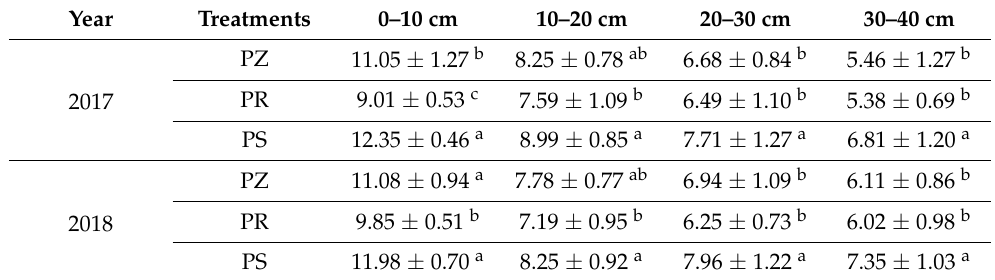
Table 5. Soil organic carbon content of plough layer under different tillage methods (g · kg − 1